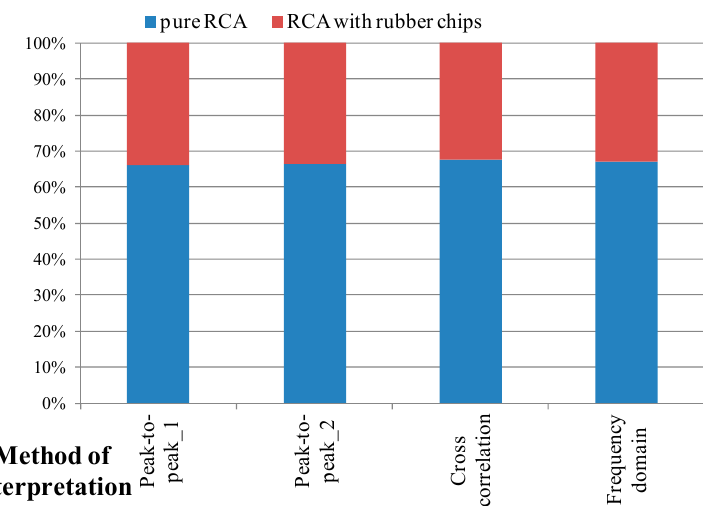
Figure 14. Percentage distribution of V S values between two different materials: pure RCA and RCA with rubber chips for p ′ = 90 kPa.